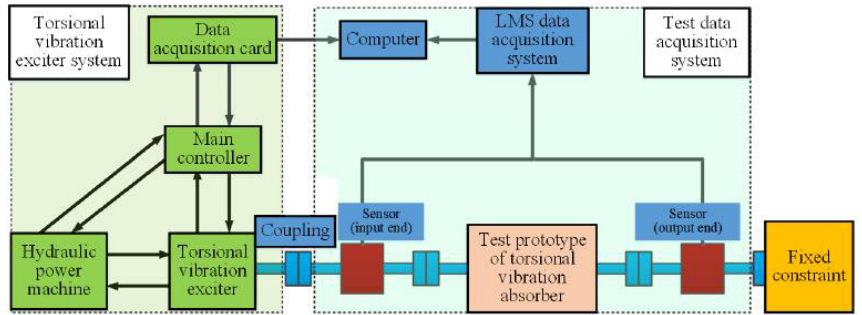
Figure 14. Schematic diagram of the torsional exciter test rig.